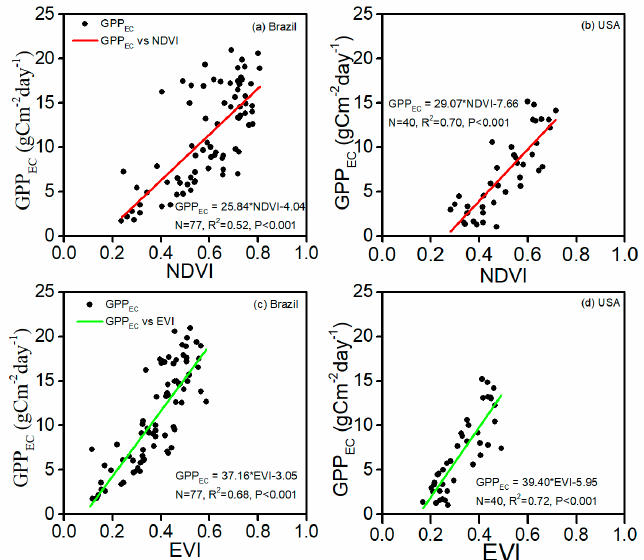
Figure 4. The connections between the estimated gross primary production(GPP EC )and two vegetation indices (NDVI, EVI) within the entire sugarcane growing season at the two sugarcane EC tower sites. ( a ) and ( c ), Brazil site, 2005–2007; ( b ) and ( d ), Louisiana, USA, 2017.